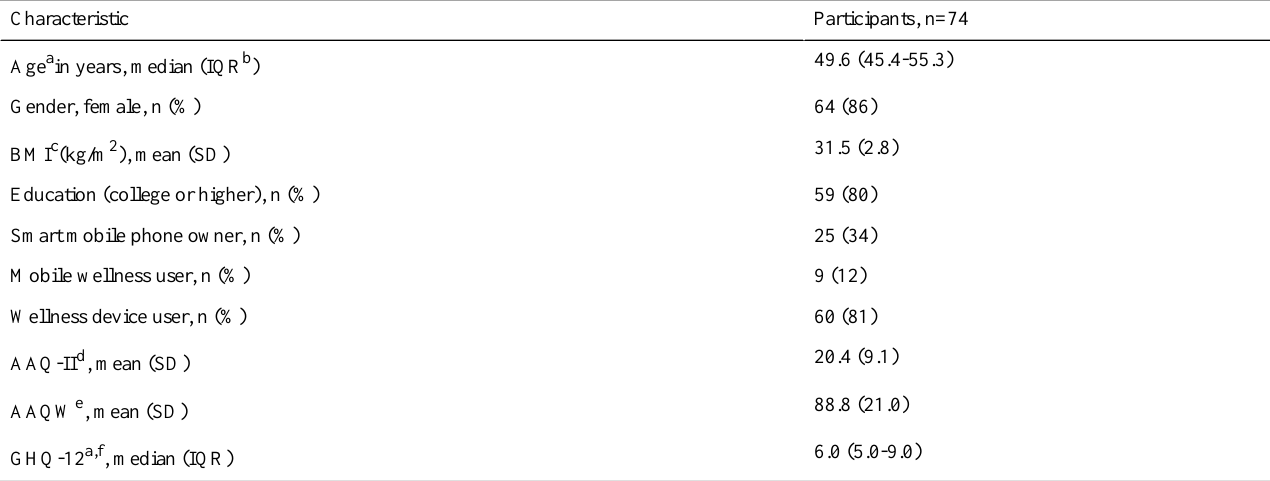
Table 2. Participants’baseline characteristics: age, gender, body mass index, education, prior technology experiences, and psychological characteristics.